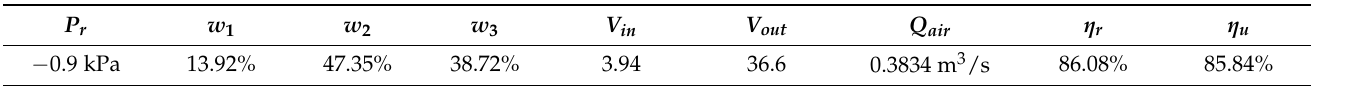
Table 4. Statistics on the recovery of the spherical recovery hood at a negative inspiratory pressure of − 0.9 kPa at 1.2 s.